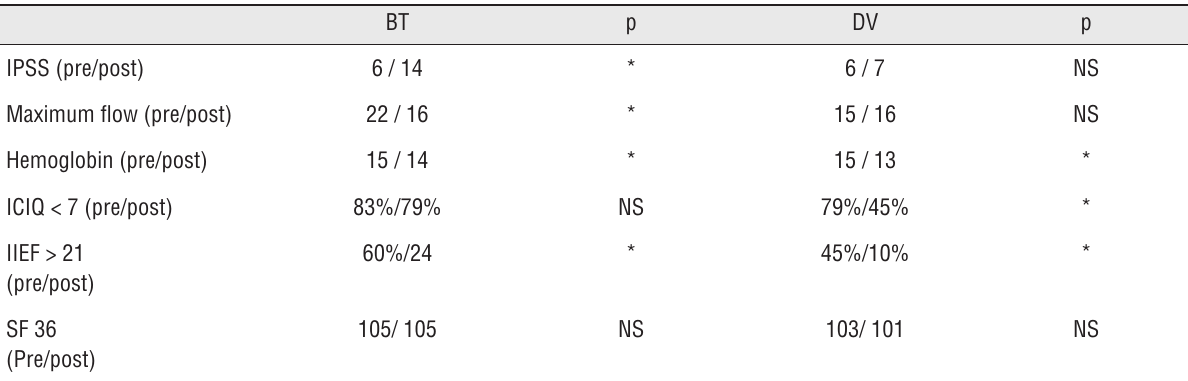
Table 2 - Comparison of pre and post-treatment outcomes in the BT and Dv